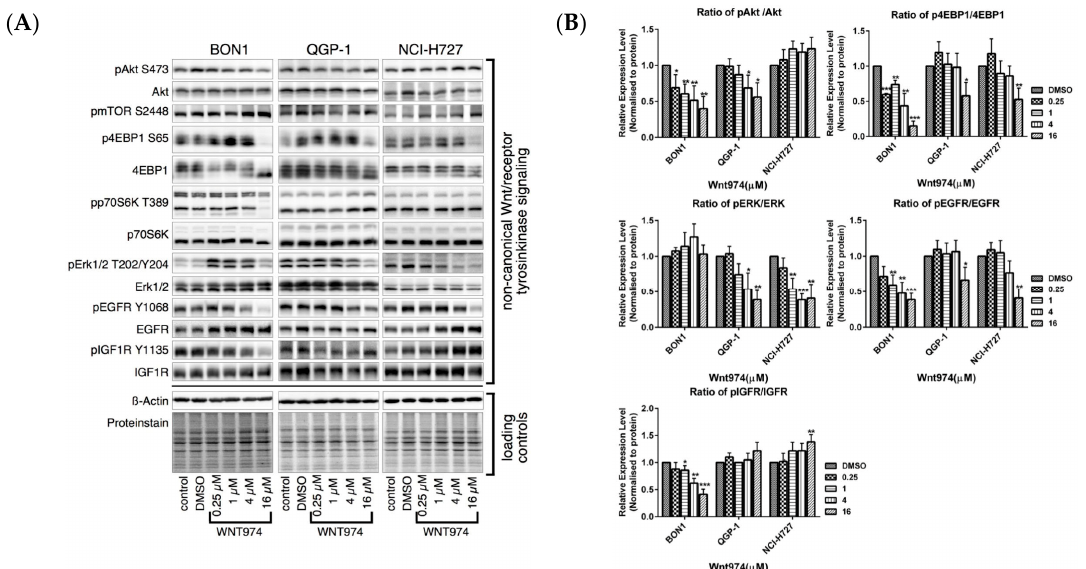
Figure 5. Effects of WNT974 on the inhibition of the pAKT/mTOR, MAPK/ERK, pEGFR and pIGFR pathways in NET cells. BON1, QGP-1, and NCI-H727 cells were treated with or without WNT974 for 72h and then subjected to Western blot analysis. ( A ) A representative Western blot is shown. Equal protein loading was verified in all Western blots by normalization to the total protein staining and by the housekeeping protein β -actin. ( B ) Densitometric quantification of Western blot data was performed. The DMSO control was set as 1.0. Relative expression levels (normalized to DMSO control) of treated cells were calculated in %. * p < 0.05, ** p < 0.01, and *** p < 0.001 compared with that of DMSO controls.